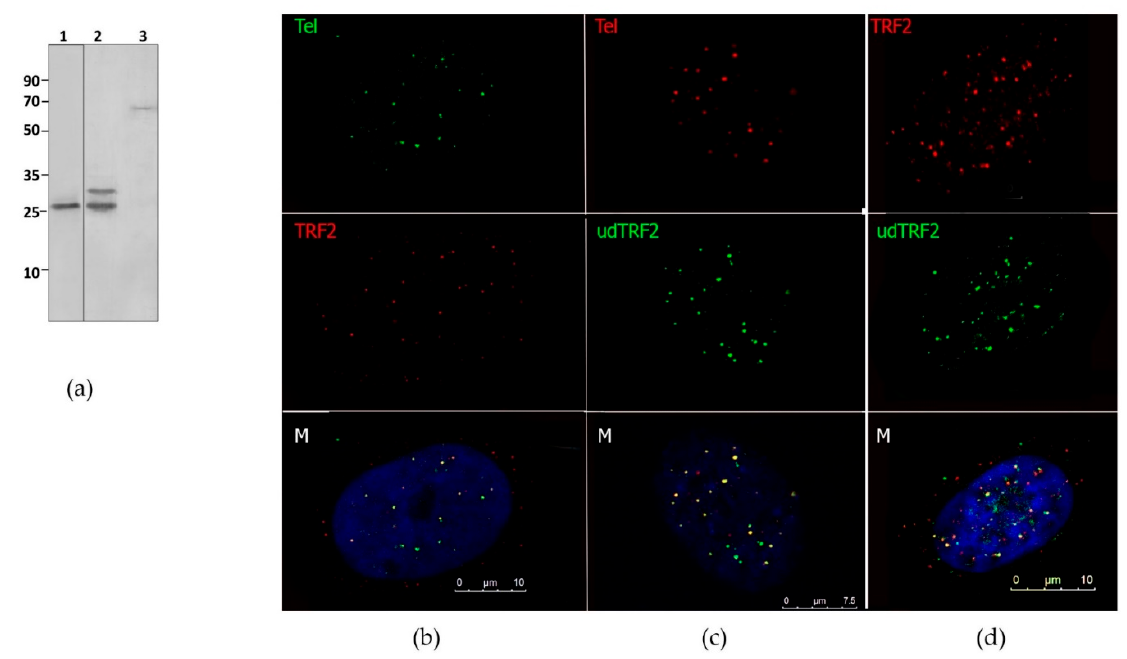
Figure 2. Antibodies (AB) against recombinant protein udTRF2 (the long linker region of TRF2). ( a ) Western blot of 1—induced bacteria lysate with commercial AB to TRF2 (Abcam); 2—induced bacteria lysate with anti-udTRF2 AB; 3—anti-udTRF2. AB reveals TRF2 in the human skin fibroblast lysate. Numbers on the left correspond to Mr of the marker. ( b ) ImmunoFISH staining of human skin fibroblasts: telomere probe—green; AB against TRF2 (ab13579, Abcam)—red. Scale bar = 10 µ m. ( c ) ImmunoFISH staining of human skin fibroblasts: telomere probe—red; AB against udTRF2—green. ( d ) Immunostaining of human skin fibroblasts: AB against udTRF2—green; against TRF2 (ab13579, Abcam)—red. Scale bar = 7,5 µ m. M—merged image. Representative confocal images, single z-slices, are shown. The results only indicate the coexistence of two molecules and do not provide any